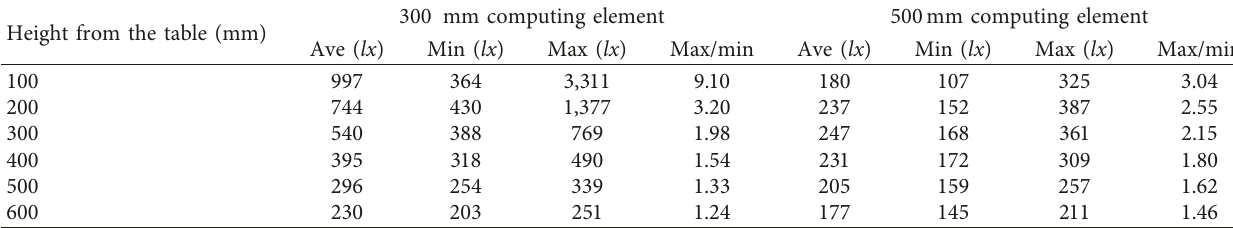
Table 2: Illumination information data of two computing elements.